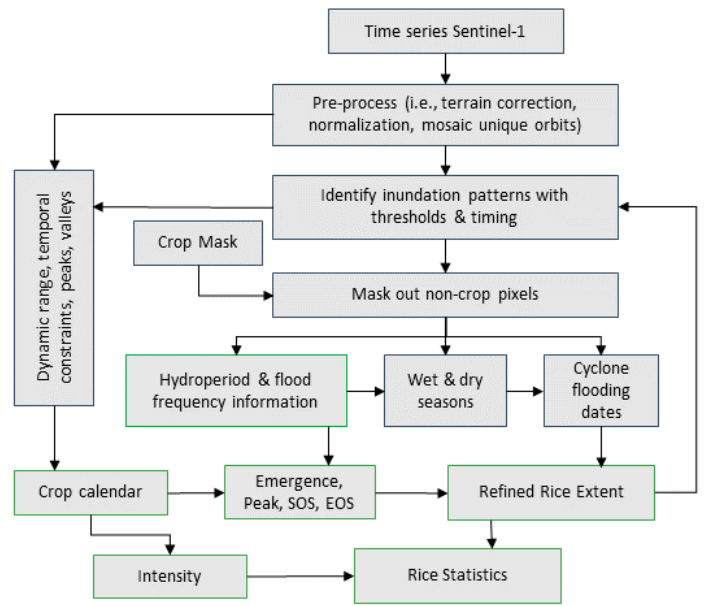
Figure 6. Work flow for refining rice information products (extent, hydroperiod, calendar, intensity, harvested area) using dense time series Sentinel-1, masks, and phenological analysis.